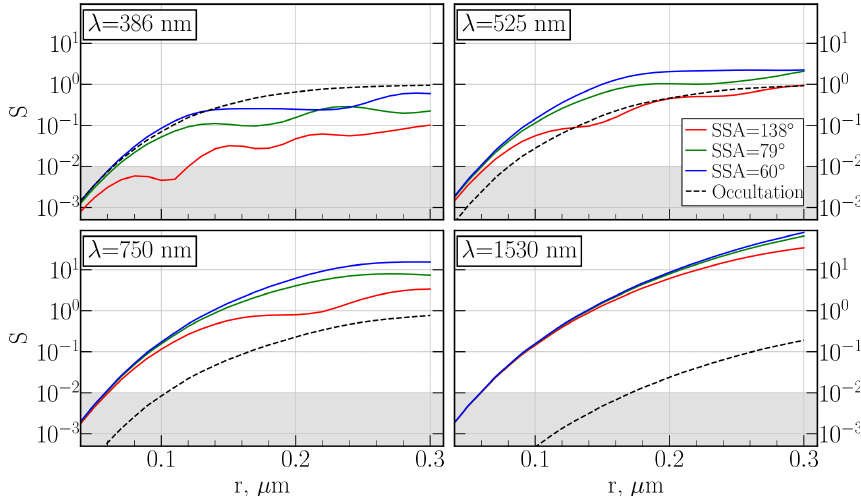
Figure 1. Modelled sensitivity, S , at 21.7km for the range of particle radii ( r ). The simulations were performed for different limb geometries with different solar scattering angles, SSA, and for one occultation